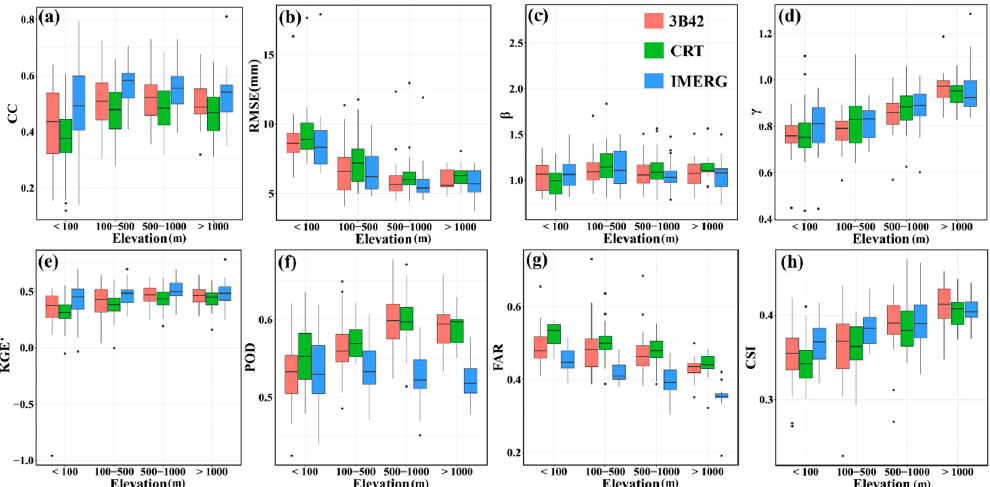
Figure 2. Box plot of grid-based metrics: CC ( a ), RMSE ( b ), β ( c ), γ ( d ), KGE’ ( e ), POD ( f ), FAR ( g ), and CSI ( h ) calculated by evaluated CRT, IMERG, and 3B42 against gauge observations at different elevation zones for the two-year study period (January 2016–December 2017).